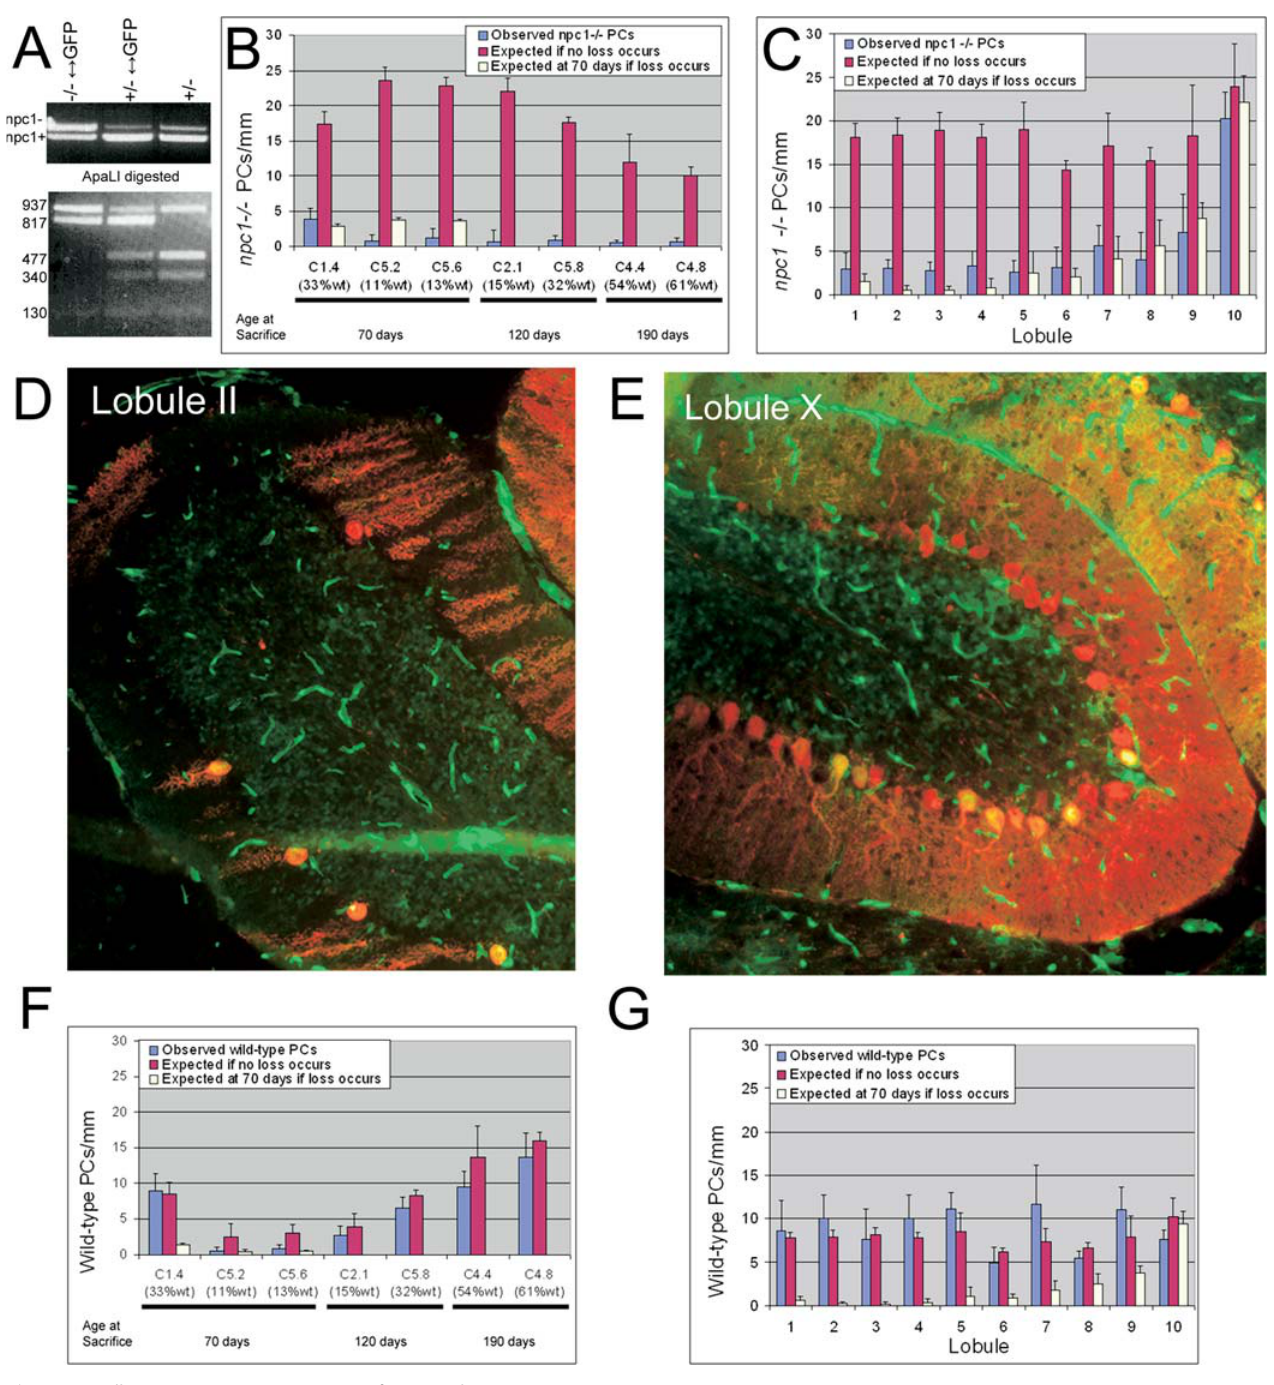
Figure 3. Cell-Autonomous Degeneration of PCs in Chimeric Mice (A) Genotyping of chimeric mice. Upper gel: PCR to amplify a fragment of the npc1 gene from npc1 (cid:1) / (cid:1) $ GFP, npc1 þ / (cid:1) $ GFP, and npc1 þ / (cid:1) mice results in npc1 (cid:1) (1,067 bp) and npc1 þ (947 bp) bands. Lower gel: The three genotypes can be distinguished by ApaLI digestion of the PCR products. The npc1 (cid:1) allele gives rise to 937- and 130-bp bands. The wild-type allele varies depending on the source: the BALB/c allele is digested to 477-, 340-, and 130-bp bands while the allele from the GFP mouse is digested to 817- and 130-bp bands. Note that the 477- and 340-bp bands are absent from the homozygous mutant chimera. (B) Quantification of npc1 (cid:1) / (cid:1) PC density in chimeric mice. For each mouse, the actual density observed (the average of the mean densities counted in each lobule) is compared to the number expected if no PC loss occurs (calculated from the density at 30 d in npc1 (cid:1) / (cid:1) mice and the chimerism percentage). Five sections separated by at least 100 l m were analyzed for each mouse. For the three mice sacrificed at 70 d, only lobules I–IX were included in the analysis because of the lack of degeneration in lobule X in npc1 (cid:1) / (cid:1) mice at this age. A value for the number of npc1 (cid:1) / (cid:1) PCs expected if loss does occur (calculated from the density at 70 d in npc1 (cid:1) / (cid:1) mice and the chimerism percentage) is also included for these three mice. No rescue of npc1 (cid:1) / (cid:1) PCs was observed for any of the chimeric mice ( p , 0.0001 for each mouse comparing observed versus expected if no loss occurs). (C) Quantification of npc1 (cid:1) / (cid:1) PC density by lobule in C1.4 at 70 d. Observed and expected densities are shown for npc1 (cid:1) / (cid:1) PCs in each lobule. No clear rescue of npc1 (cid:1) / (cid:1) PCs was observed in any lobule ( p . 0.05 for all lobules comparing observed versus expected if loss occurs, except II and III, where p - value is between 0.01 and 0.05; p , 0.001 for all lobules comparing observed versus expected if no loss occurs, except lobule X, where p . 0.05). PLoS Genetics |